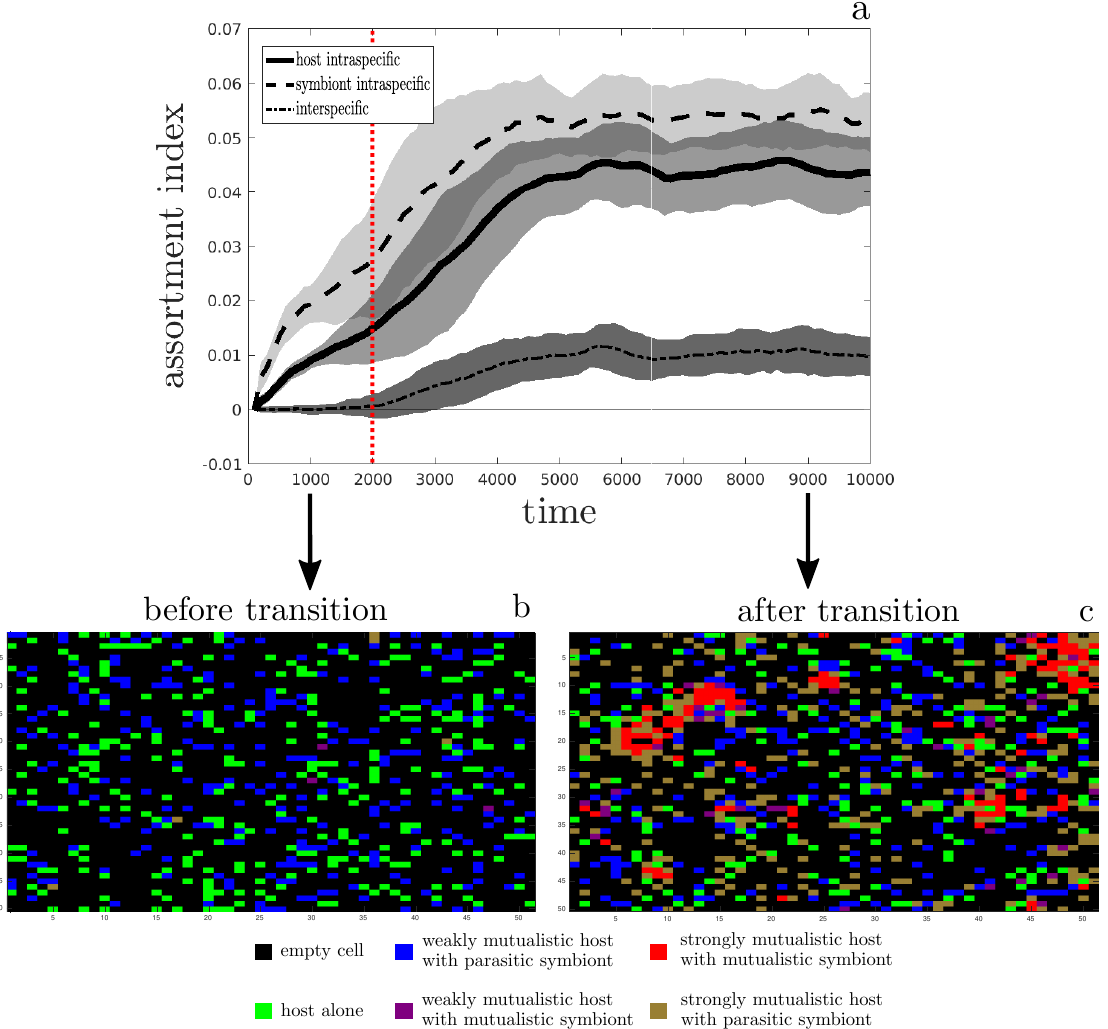
Figure 4. a) Spatial structures are described by the assortment index measuring the intraspecific assortment between hosts (plain line), the intraspecific assortment between symbionts (dashed line) and the interspecific assortment between hosts and symbionts (dash-dot line). Results are averaged over 100 simulations with strong competition γ C = 0 . 2 and no dispersal cost d = 0 . The time series are adjusted so that all simulations have a transition time t = 2000 (red dotted line). Grey areas show the standard deviation. The threshold separating mutualistic and antagonistic symbionts is as in Figures 1 and 3. b)-c) Snapshots of a region of 40x40 cells before (panel b) and after (panel c) the transition to mutualism. For the sake of the figure, a host is considered weakly mutualistic if its interaction trait is less than 0 . 5 and strongly mutualistic if it is greater h = 0 . 1 , f s = 2 . 5 , f max = 8 , f a = 0 . 5 and than 0 . 5 .Other parameters are m = 0 . 06 , c m = 0 . 3 , w h = 1 , f min min β max = 0 .